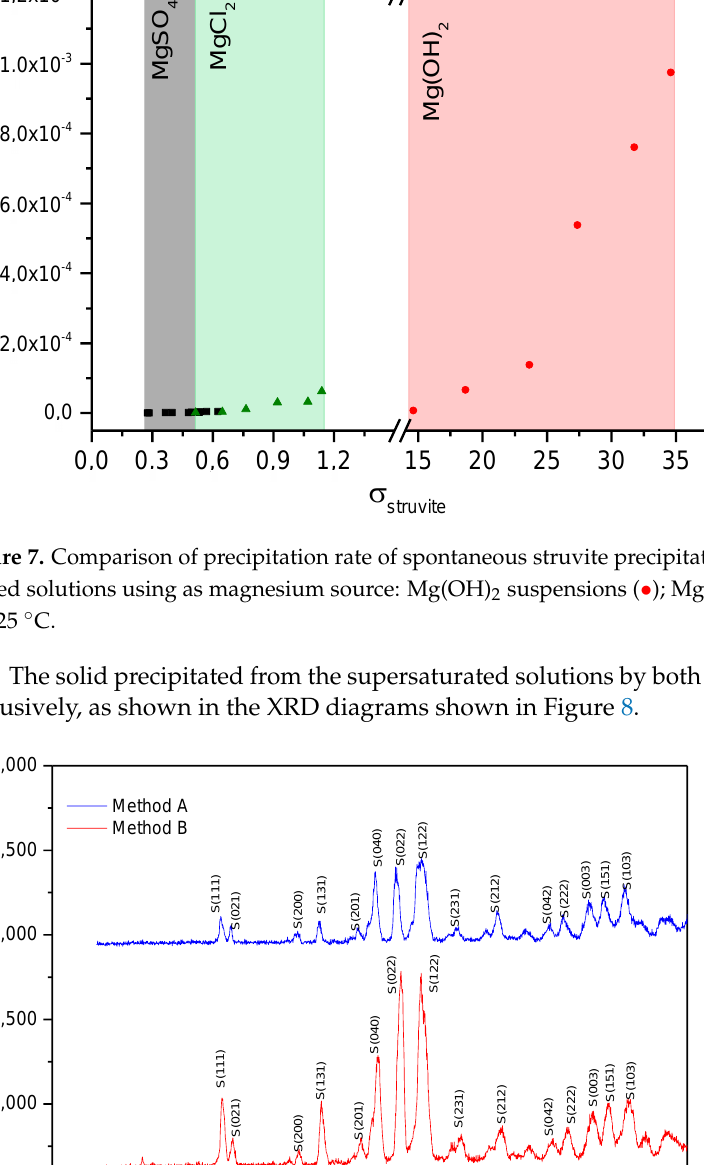
Comparison of the recovery rate of phosphorus from supersaturated solutions with respect to struvite (Figure 7), using brucite (from hydrothermal treatment of MgO), magne- sium chloride [28] and magnesium sulfate [29] as a magnesium source, showing that in the first case, the rates were quite higher for higher values of relative supersaturation, which could also lead to more efficient phosphorus recovery.